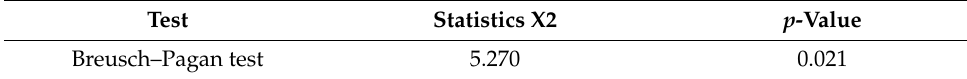
Table A8. The results of the variance heterogeneity test of the second model.